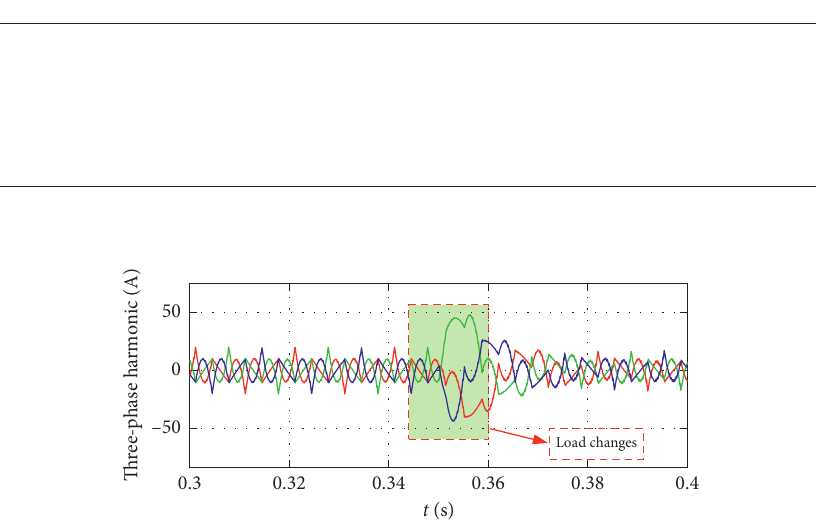
Figure 8: Three-phase harmonic current detected by the instantaneous reactive power method.